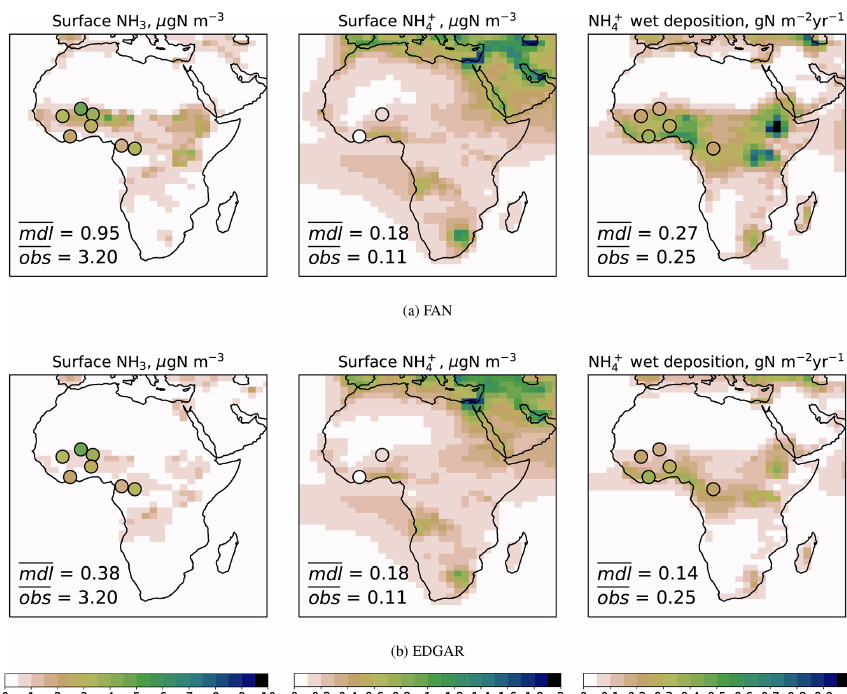
Figure 9. Modeled (shading) and observed (markers) for ammonia (left) and ammonium (middle) concentrations and wet deposition fluxes (right) for Africa in the FAN (a) and EDGAR (b) simulations. Modeled and observed values averaged over the stations are shown in the lower-left corner of each